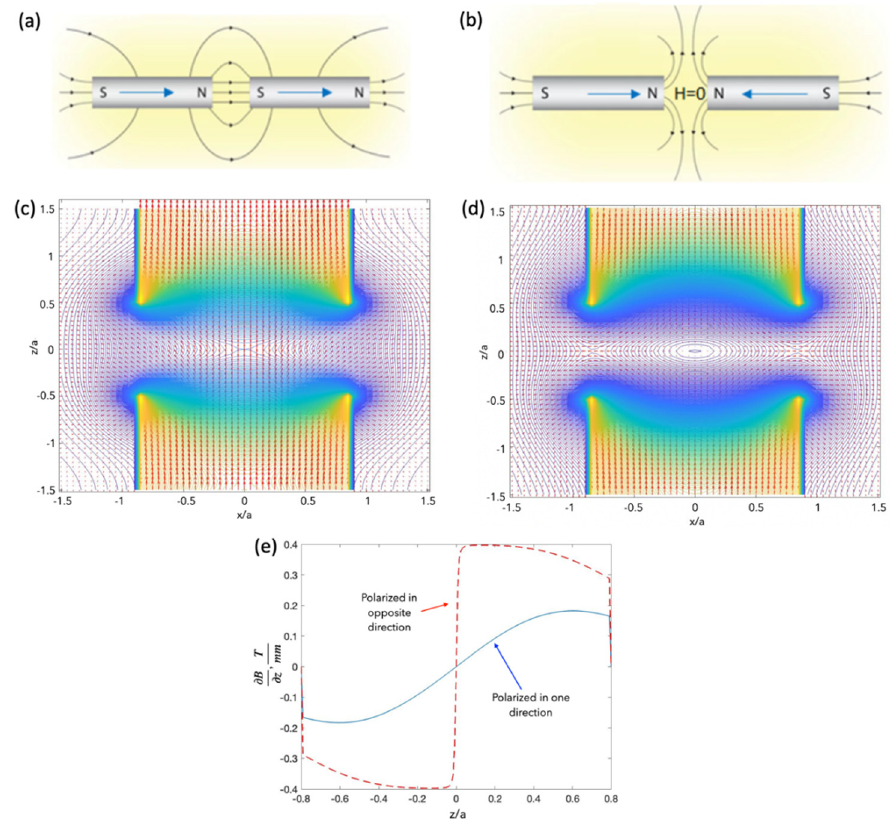
Figure 6. Schematics of magnetic field configuration with two axially magnetised cylinders: ( a , c ) cylinders with the same magnetisation; ( b , d ) oppositely magnetised cylinders. Closely spaced magnets with the same polarisation produce a nearly uniform magnetic field between N and S poles, whilst the magnets with opposite polarisation have a zero-field point (between alike poles) in the centre of the magnet system. ( e ) Gradient of magnetic induction. Calculations in ( c – e ) were performed for typical permanent magnets (NdFeB magnets with the surface field of 0.66 T).